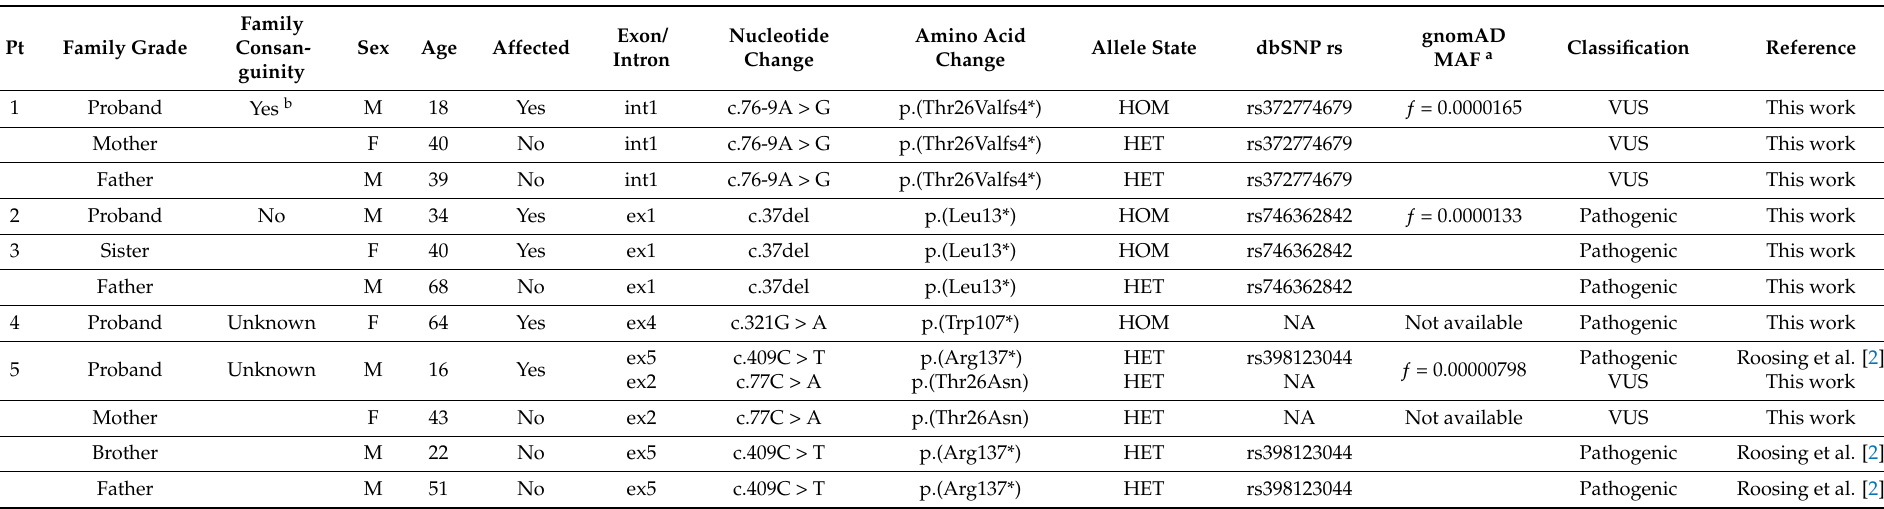
Table 2. Demographic and genetic characteristics of RAB28 families. Mutations refer to the following entries in GenBank (https://www.ncbi.nlm.nih.gov/genbank): NG_033891,